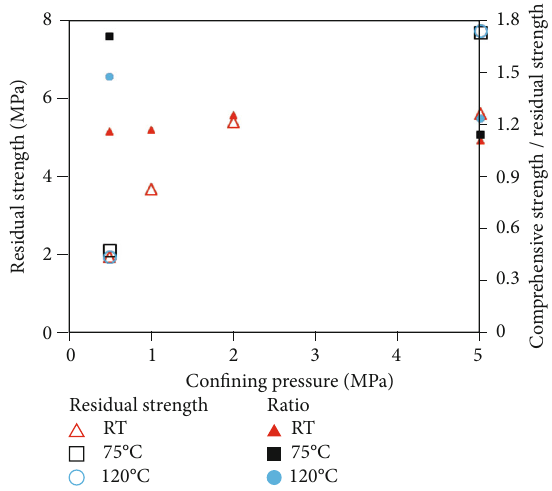
Figure 10: Characteristics of oil sand residual strength under di ff erent con fi ning pressures and temperatures (the hollow and solid shapes represent the residual strength and ratio of compressive strength to residual strength, respectively).